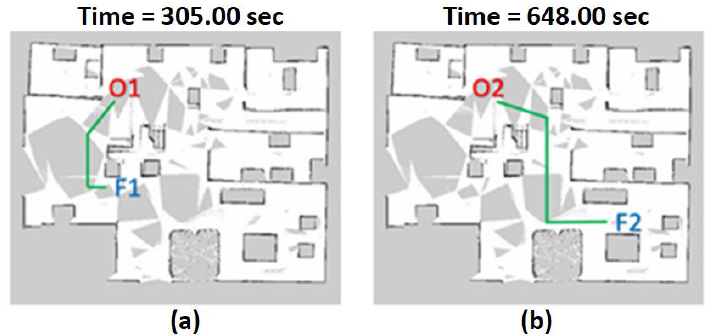
Figure 12. Example of the time for different paths. In this example, in the simple path ( a ), the robot requires less time to arrive to the target point in comparison with the complex path ( b ).